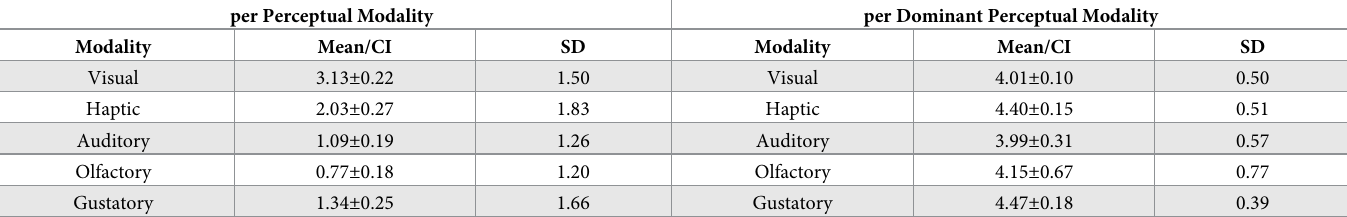
Table 1. Mean strength ratings (0–5) for the monosyllabic words, 95% confidence intervals, and standard deviations per perceptual modality and per dominant per- ceptual modality.